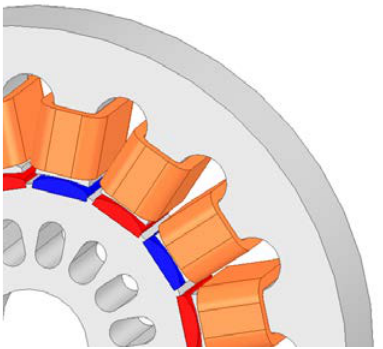
Figure 4. Fragment of a CM segment with tooth coil winding .